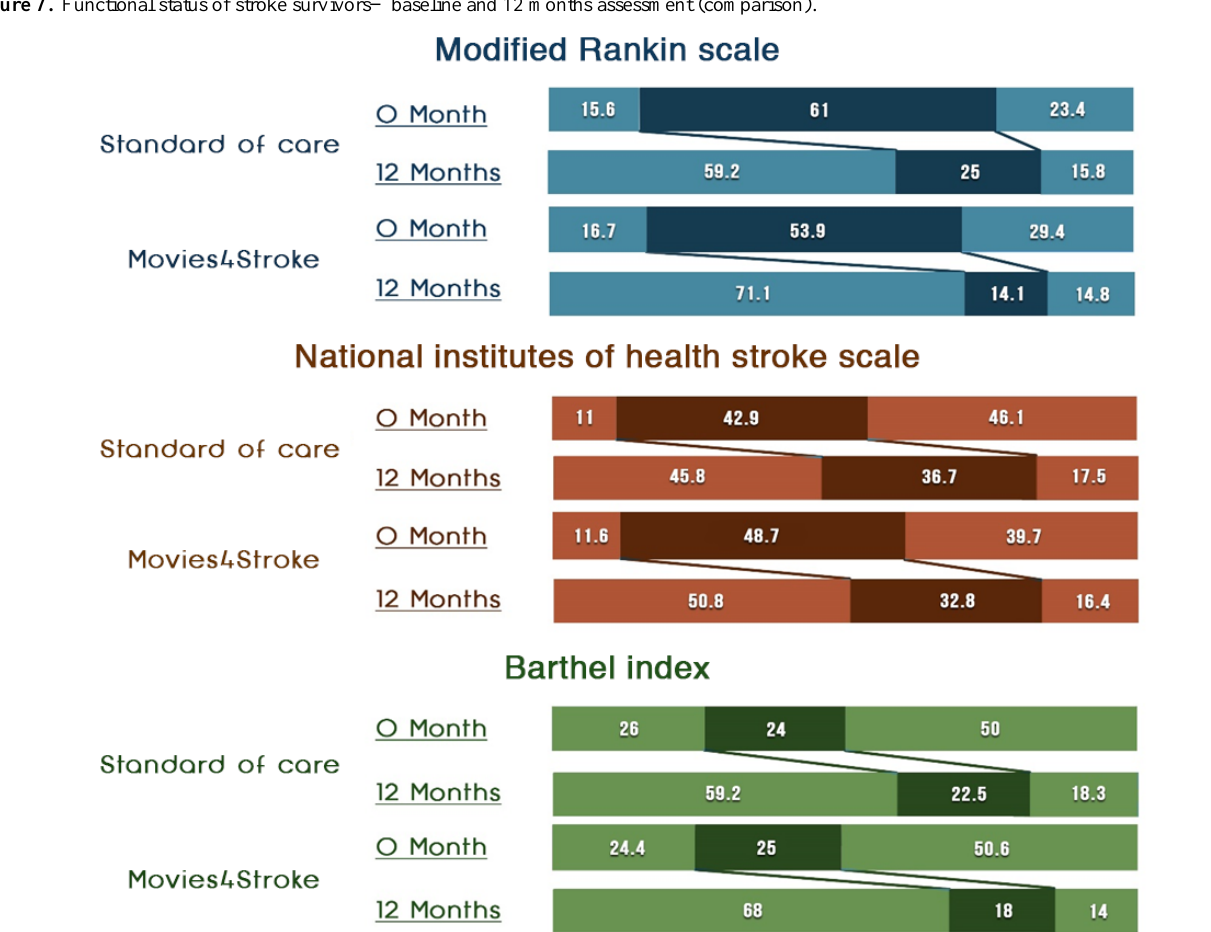
Figure 7. Functional status of stroke survivors—baseline and 12 months assessment